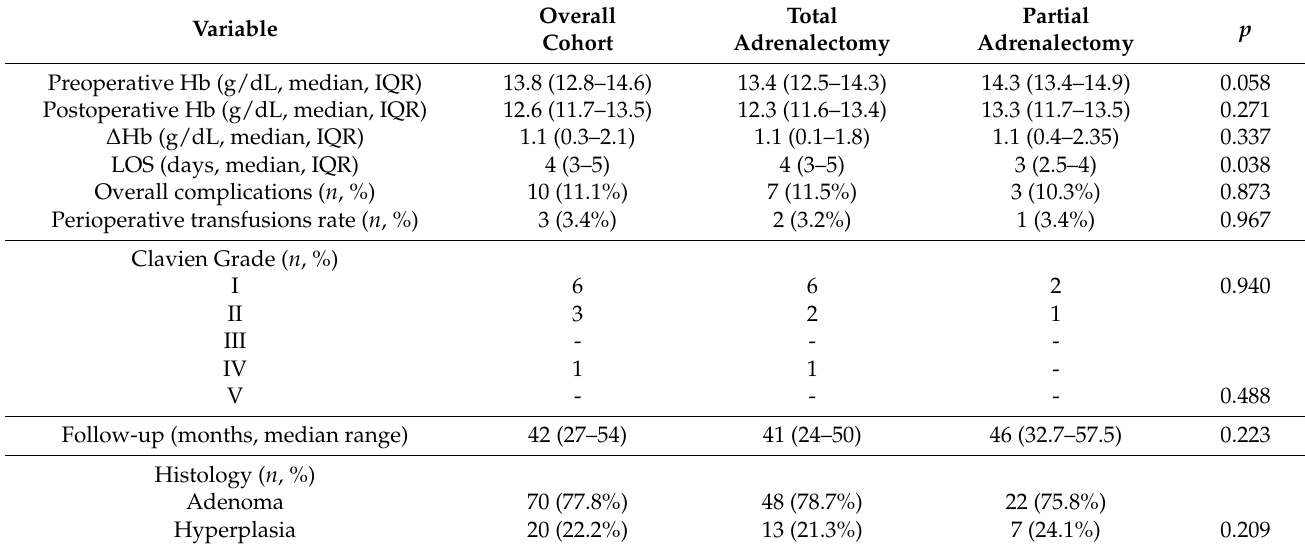
Table 3. Perioperative and pathologic outcomes.